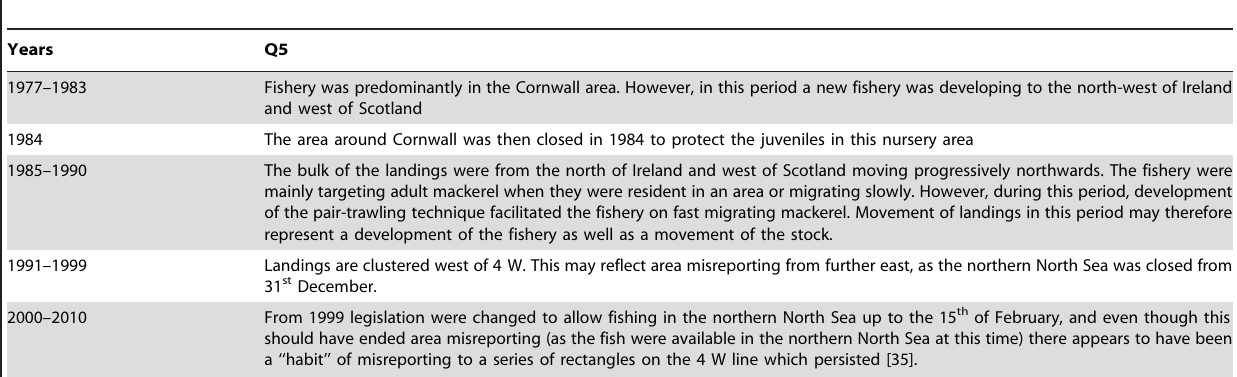
Table 2. Factors affecting spatiotemporal distribution of the commercial fishery in